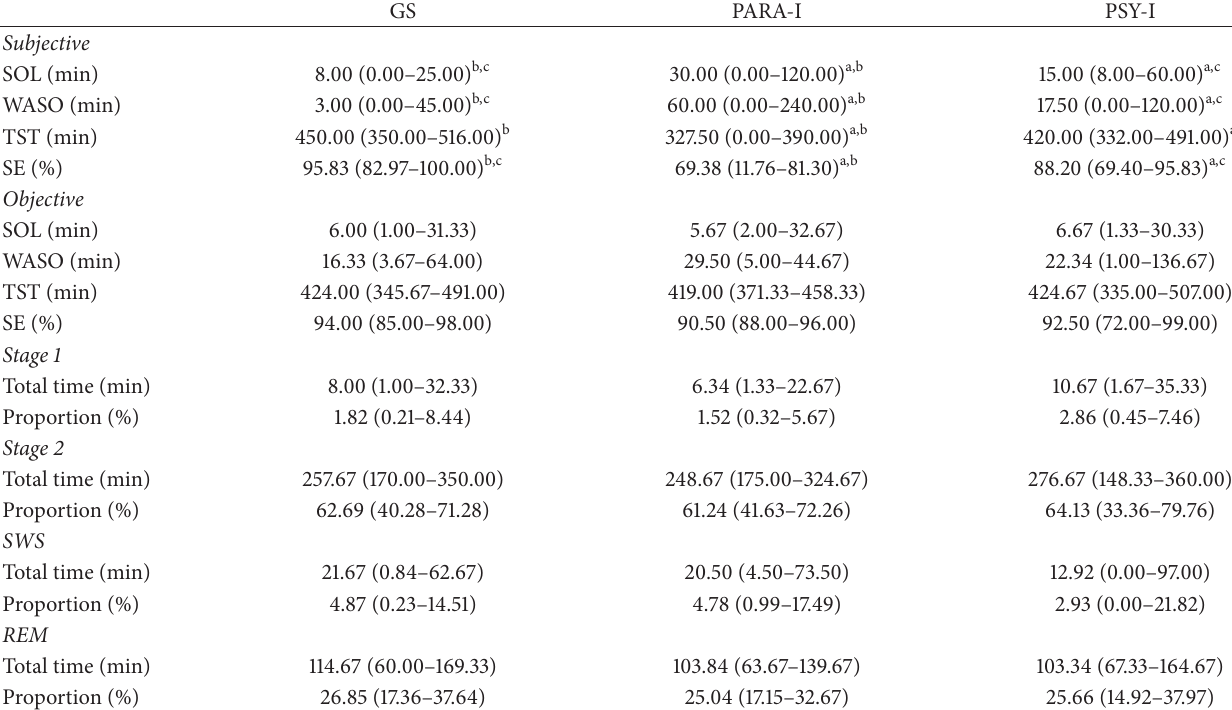
Table 2: Medians (ranges) of laboratory night 3 objective and subjective sleep parameters of good sleepers (GS) and paradoxical (PARA-I) and psychophysiological (PSY-I) insomnia